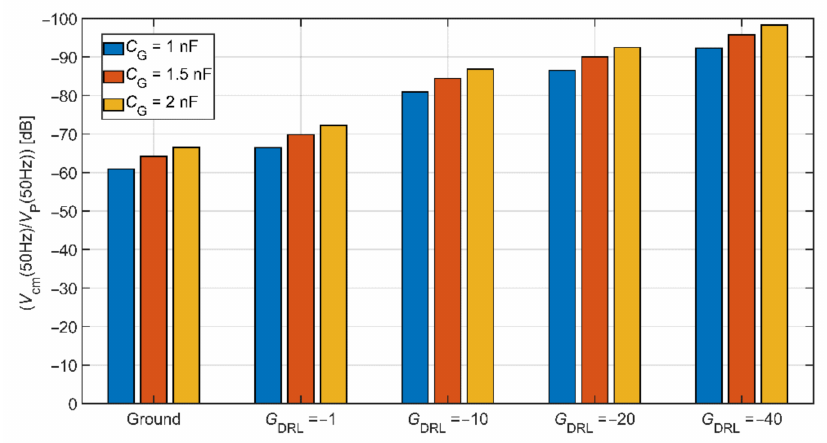
Figure 10. The comparison of common-mode rejection depending on different DRL